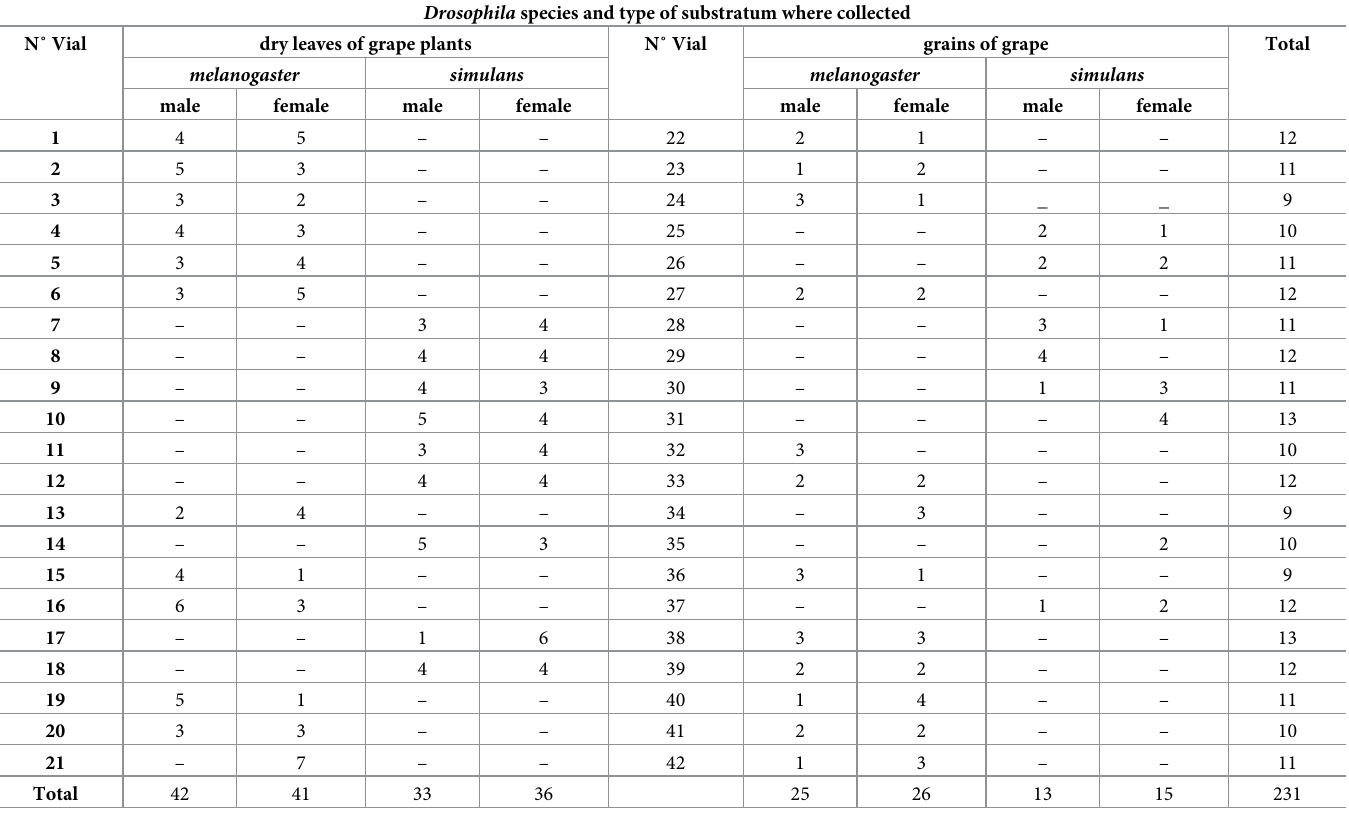
Table 1. Number of male and female D . melanogaster and D . simulans collected from dry leaves and grains of grapes on the ground. Each collected group of flies was deposited into a vial. The sexes of individuals in each sample vial were taxonomically identified. Drosophila species and type of substratum where